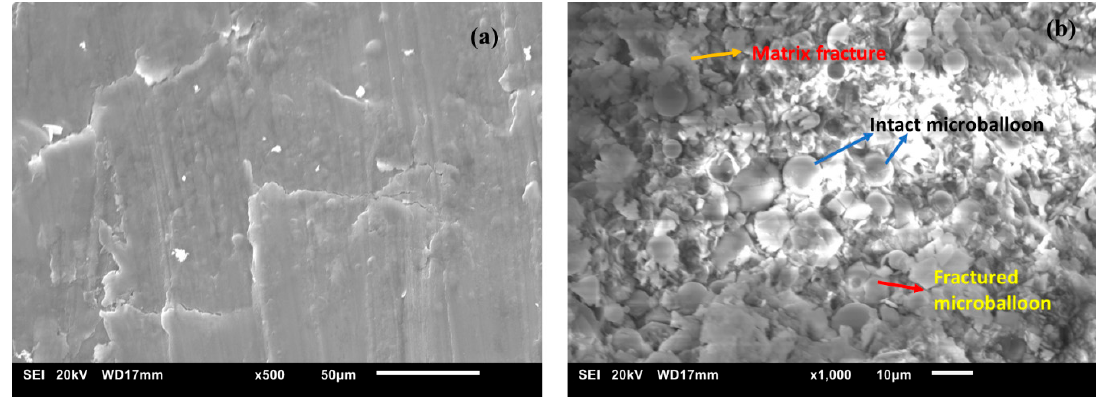
Figure 8. Fractography analysis of as-cast ( a ) pure Mg, and ( b ) Mg/Mg-20GMB hybrid composite.